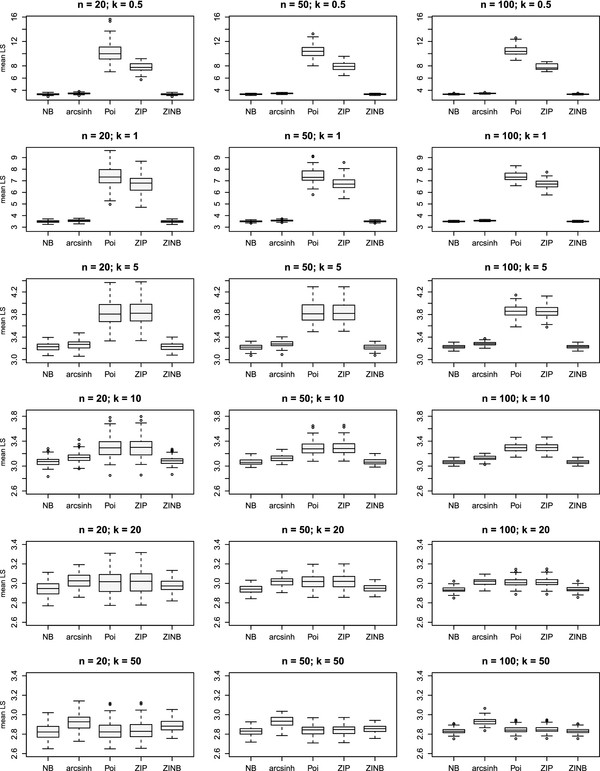
Simulation study: Discriminatory power of DIC and LSÂ¯for different scenarios (100 runs per scenario). Data generating process: longitudinal, negative binomial counts with subject-specific intercept (balanced design); modeling strategy: Poisson GLMM with random intercept; number of subjects per group: n = 20,50,100; degree of overdispersion: k = 0.5,1,5,10,20,50. As k→∞, the degree of overdispersion decreases and the negative binomial converges to a Poisson distribution. Hence, DIC and LSÂ¯ decline. Note that the range of DIC increases in the case of a larger sample size.